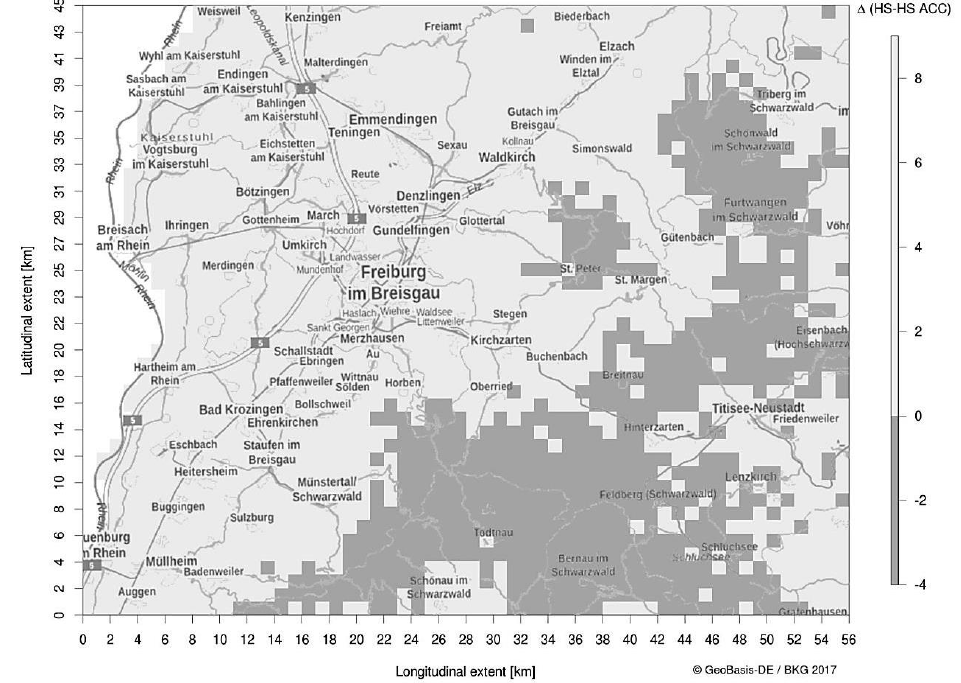
Figure4. Spatialdistributionofthemeandi ff erencebetweenHSdays(heatstresswithoutacclimatisation Figure 4. Spatial distribution of the mean difference between HS days (heat stress without acclimatisation effect) and HS ACC days (heat stress acclimatisation effect) during the time period e ff ect) and HS ACC days (heat stress acclimatisation e ff ect) during the time period 1995–2012. Negative 1995–2012. Negative differences (dark grey) imply an increase in days with heat stress due to the di ff erences (dark grey) imply an increase in days with heat stress due to the acclimatisation e ff ect, and acclimatisation effect, and positive differences (light grey) imply a decrease in days with heat stress. positive di ff erences (light grey) imply a decrease in days with heat stress. Atmosphere 2018 , 9 , x FOR PEER REVIEW